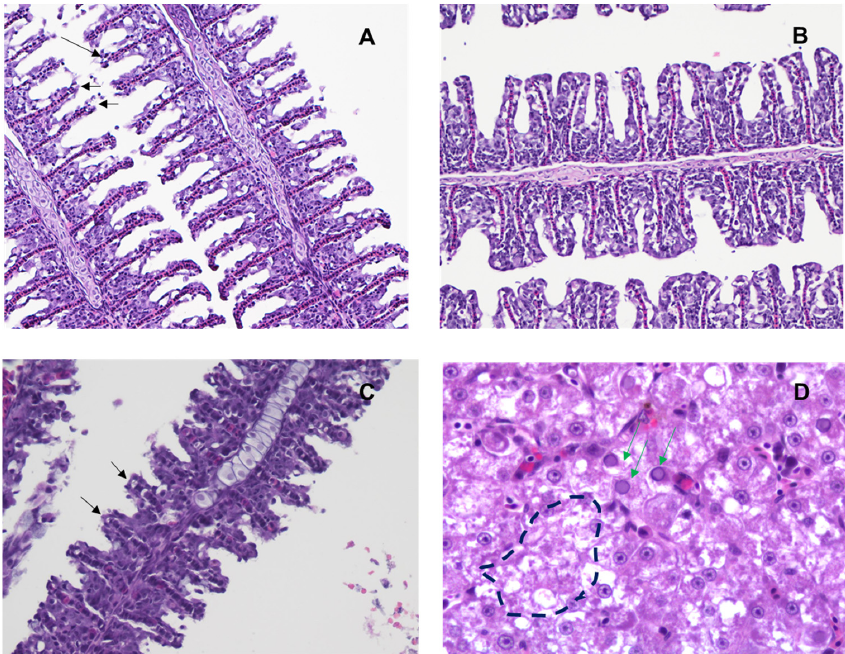
Figure 8. Histopathology of tissues from young koi collected on days 7 and 10 post-infection. ( A ) Gills with mild lymphocytic branchitis, sloughing of epithelial cells, and slightly shorted filament (black arrow) from the ML324-treated group. ( B ) Uninfected koi gills. ( C ) Gills with moderate lymphocytic branchitis, hyperplasia, and shorter filament (black arrow) from the DMSO-treated group. ( D ) Livers from koi that died after CyHV-3 infection from the ACV-treated group. Intranuclear inclusion bodies (green arrow) and necrosis (broken circle) were seen in liver sections. Hematoxylin and eosin (H&E) staining, 200×.